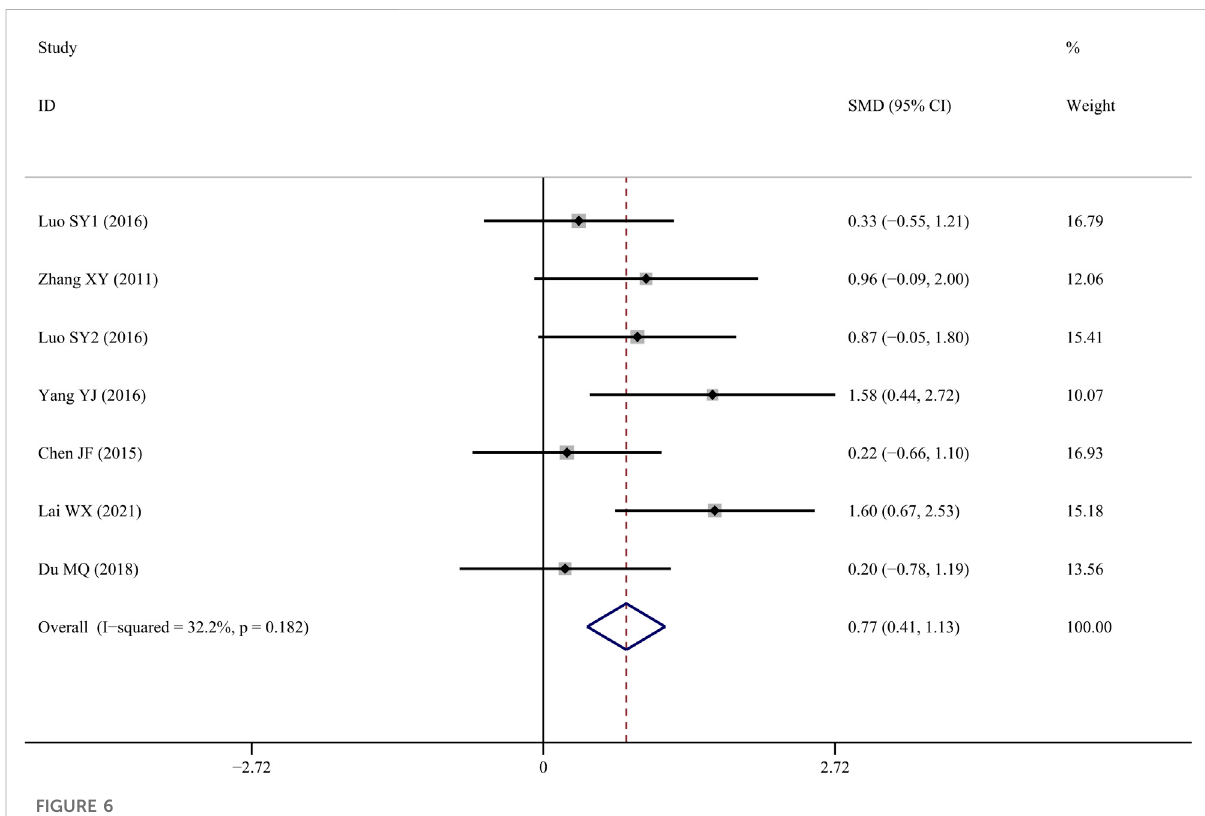
FIGURE 6 Effect of tanshinol on Tb.Th change in OP